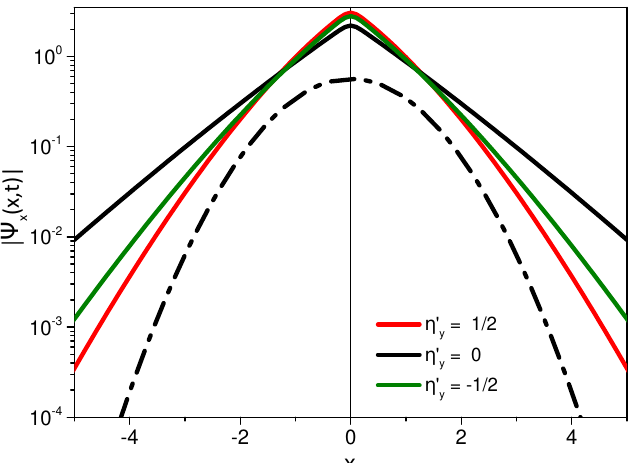
Figure 5. | Ψ x ( x , t ) | vs. x , for different values of η (cid:48) y . The dashed-dotted line corresponds to the wave √ π , which was incorporated for comparative purposes to evidence the effect function Ψ x ( x ) = e x 2 /2 / (cid:48) of η (cid:48) y (cid:54) = 1 on the solutions of the Schrödinger equation. The curves are drawn for ¯ hlt η y / ( 2 m ) = 1, √ l = 1 and the initial condition ϕ x ( x ) = e − x 2 / ( 2 σ 2 ) / ( πσ 2 ) , with σ 2 = 0.01.